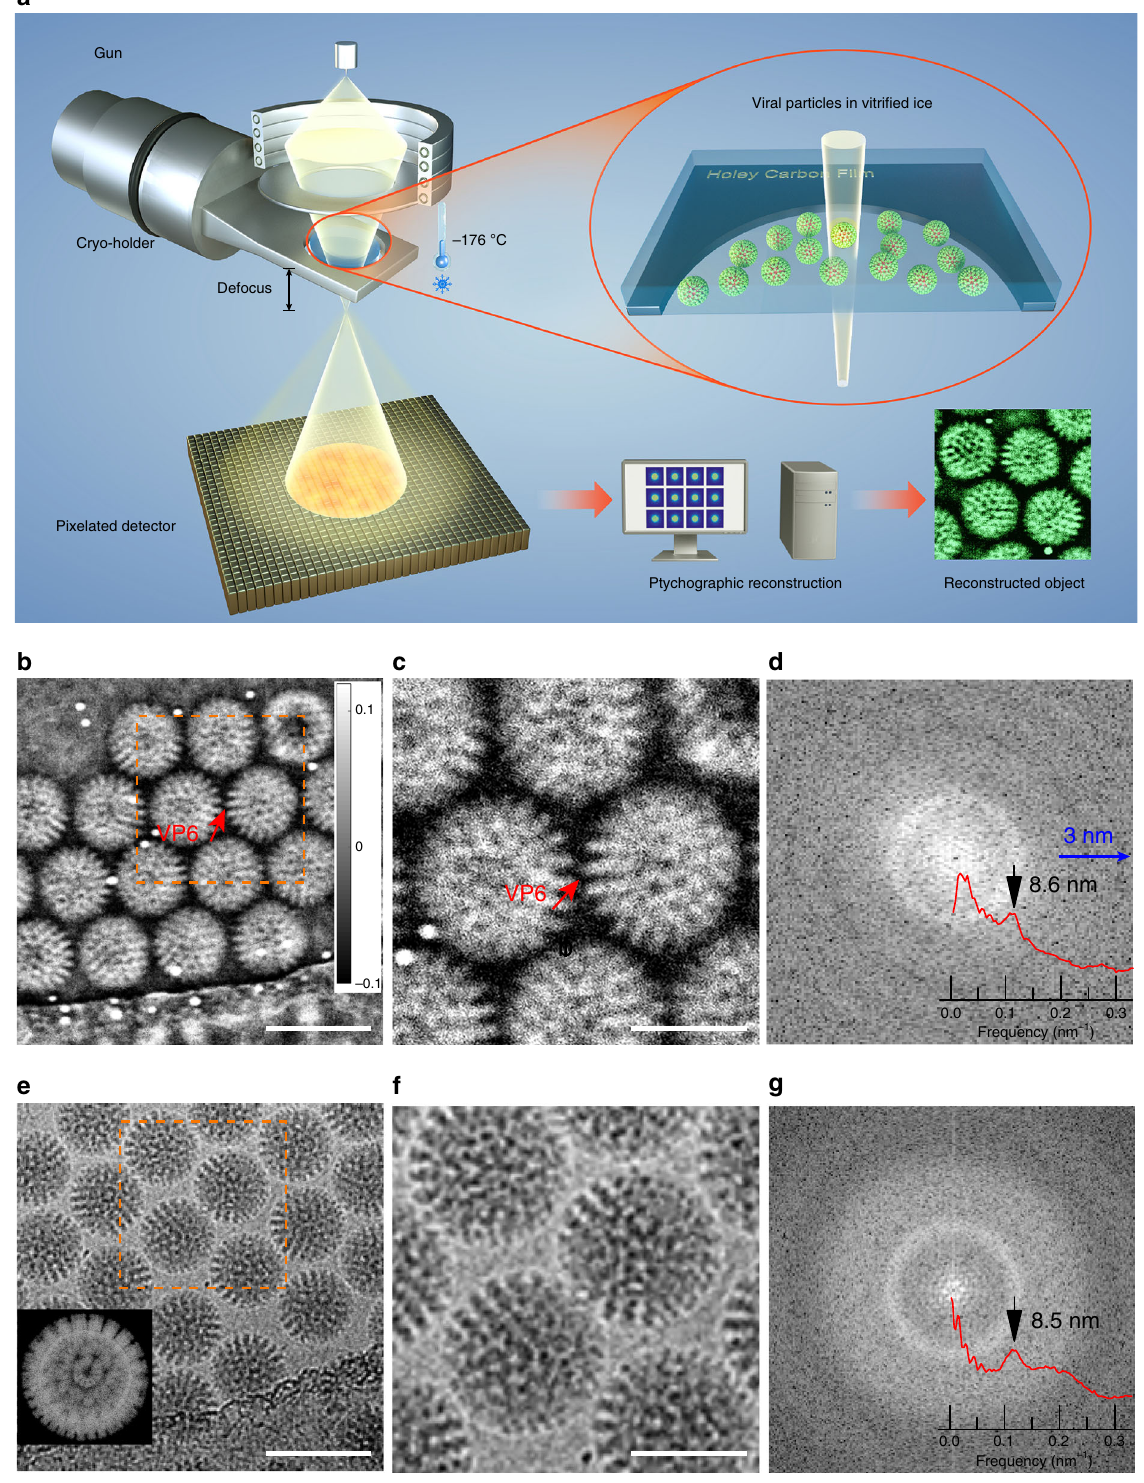
Fig. 1 Cryo-ptychographic con fi guration and reconstruction of rotavirus DLPs. a Schematic diagram of the optical con fi guration. b Ptychographic reconstructed phase at a dose of 22.8 e/Å 2 and e defocused TEM images at dose of 35 e/Å 2 of rotavirus DLPs in vitri fi ed ice. c , f Magni fi ed views of sub areas marked in b and e with orange squares, respectively. The red arrows in b and c indicate the capsid trimers of viral protein 6 (VP6). The ~6 nm gold particles are displayed as bright features in b and c following established convention where a phase advance ( + ) is displayed as white 53 and appears as a contrast reversal compared to conventional TEM images. d , g Power spectra calculated from b and e , respectively including radial averages (inset). A rotavirus DLP model is shown in e (inset). The gray scale bar in b is in radians and applies to b and c . Scale bars: 100 nm in b and e , 50 nm in c and f